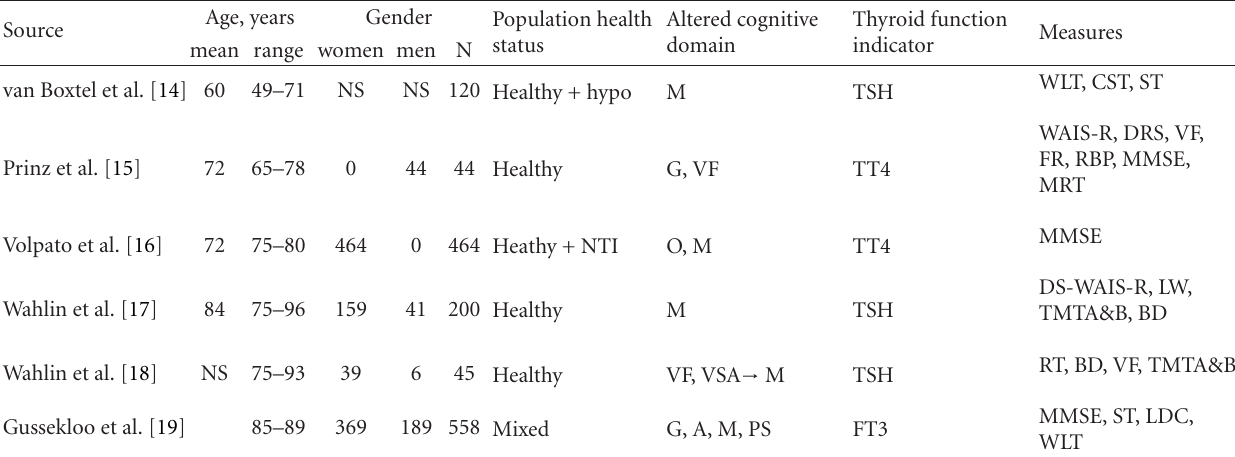
Table 2: Relation between thyroid function and cognition in euthyroid elderly ( > 65 years old) (A: attention; BD: block design of WAIS-R; CST: concept shifting test; DRS: dementia rating scale; DS: digit span forward and backward of WAIS-R; FR: figure rotation; FT3: free T3; G: global; LDC: letter digit coding test; LW: list of words; M: memory; MMSE: Mini-Mental State Examination; MRT: median reaction time tests; NS: not specified; NTI: nonthyroidal illnesses; O: orientation; PS: psychomotor speed; RBP: Rivermead behavioral profile; ST: